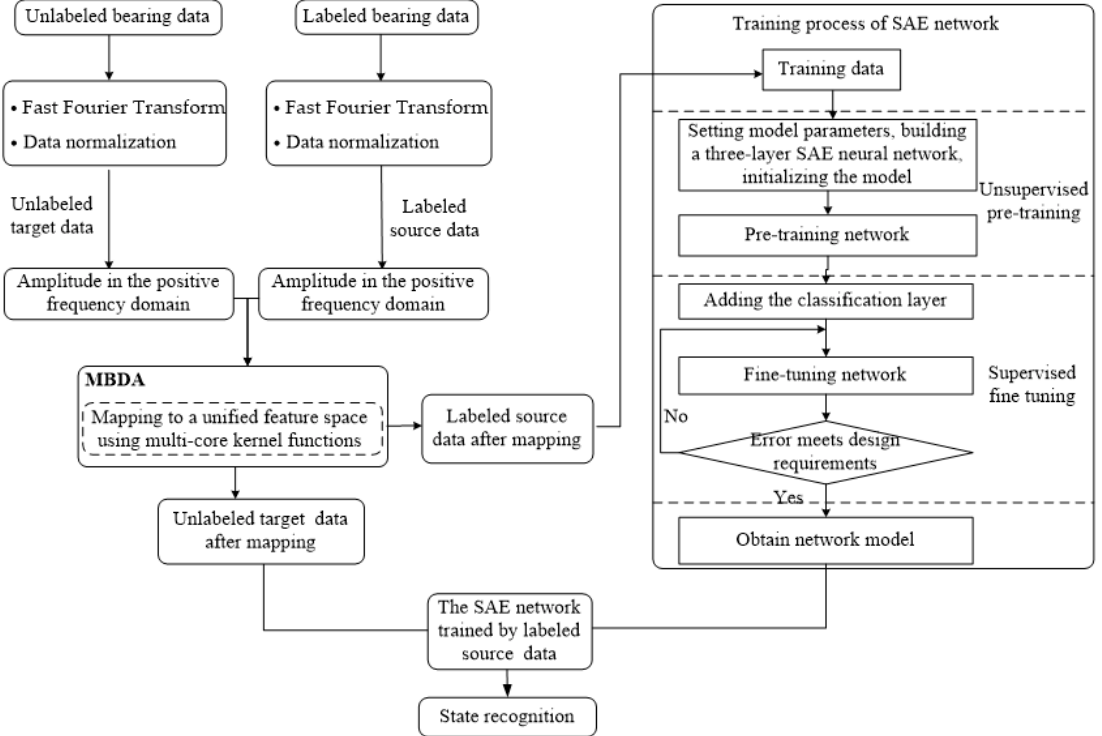
Figure 3. Flowchart of the bearing state recognition method under di ff erent working